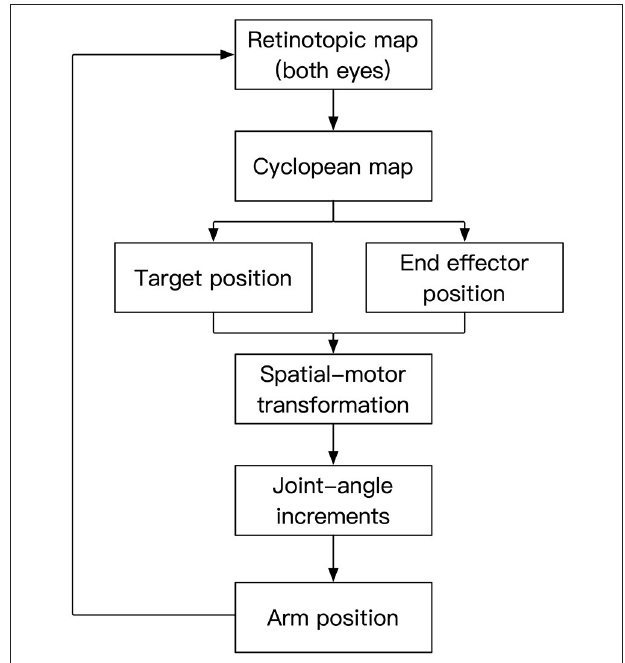
FIGURE 1 | Processing stages of the model. Two-dimensional retinotopic maps from the left and right eyes are combined into a cyclopean map to reveal depth information. This information is used to represent target and end-effector positions in an exocentric reference-frame. The spatial position information is then converted to equivalent motor representations, which in turn drive the movements of the joints to have the end effector reach the target position. The visual input corresponding to the moving arm established a feedback loop to control the